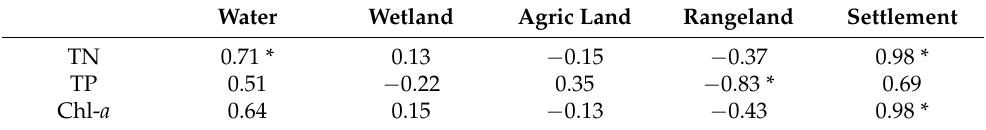
Table 6. Correlation between LULC classes and water quality within Lake Kyoga’s immediate catchment. Water Wetland